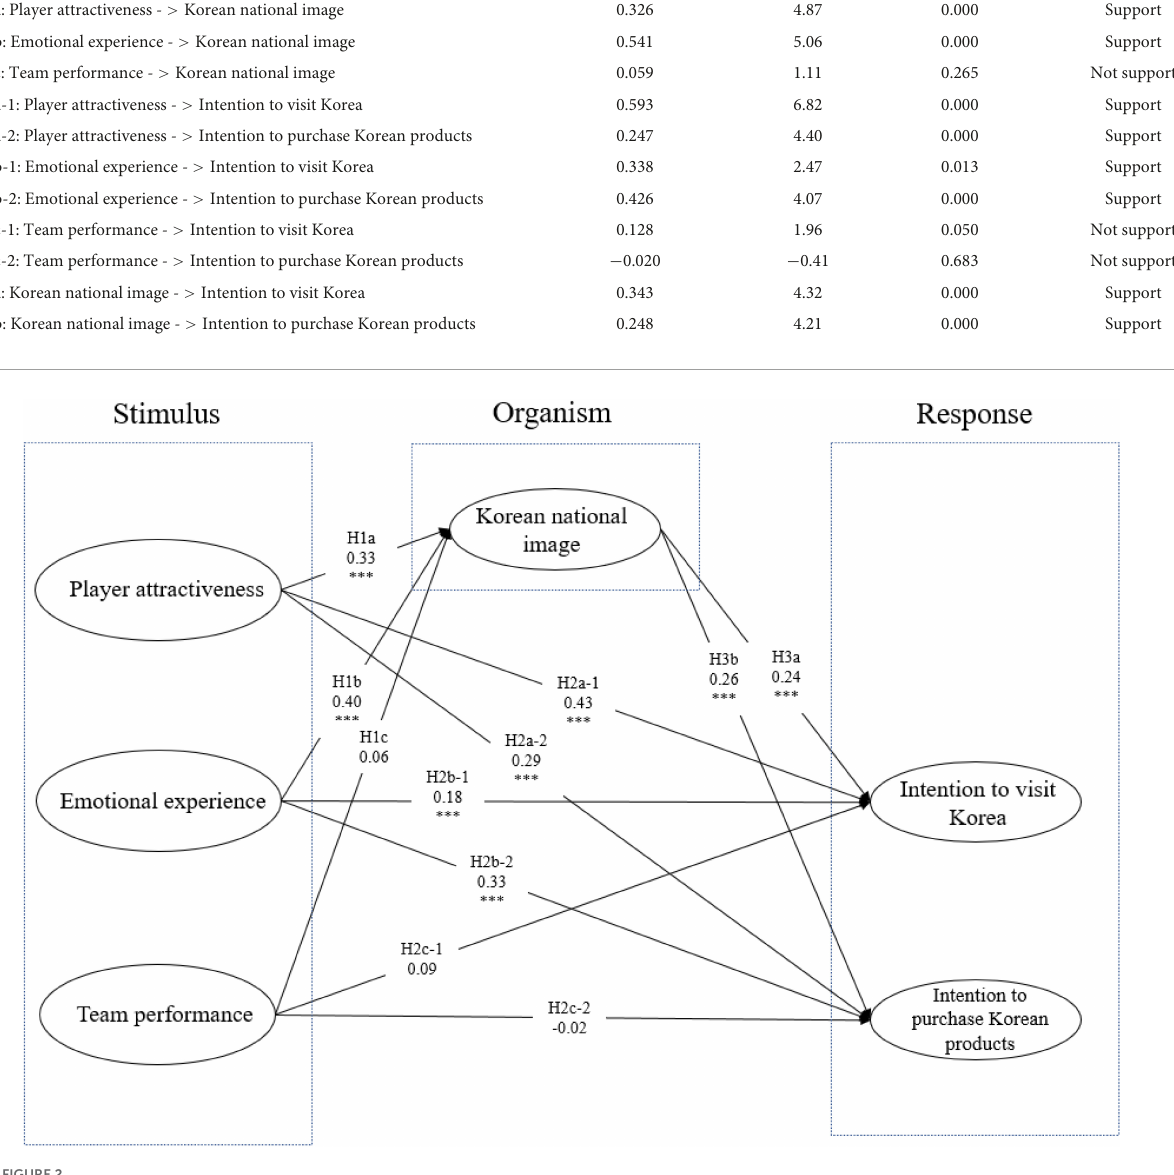
FIGURE2 Result of structural equation model. Model Fit: x 2 = 487.32, df = 233, x 2 /df = 2.617, TLI = 0.935, RMSEA = 0.075. ∗∗∗ p <